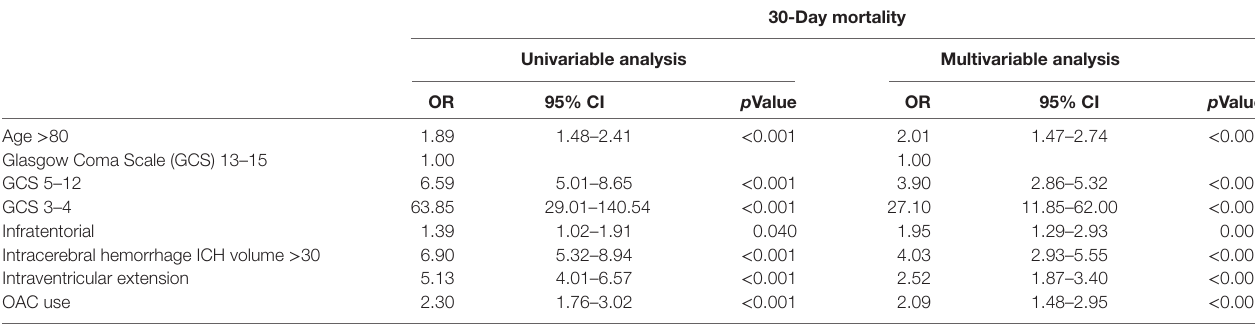
TaBle 2 | Univariable and multivariable logistic regression analysis for variables predicting 30-day mortality.